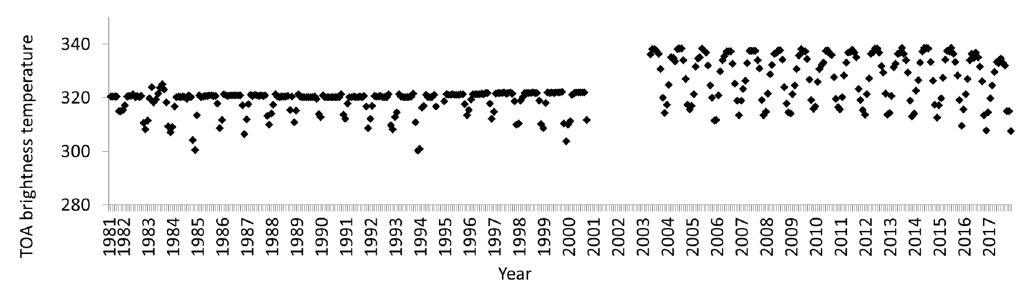
Figure 5. Difference between AVHRR2/3 in a Sahara Desert pixel of channel 3 (3.55–3.93 µm). The saturation between AVHRR2/3 was different: AVHRR2 was saturated at 50 °C and AVHRR3 at 63 °C. Therefore, before 2000 (AVHRR2), the data were distributed in a narrower range than after 2000 (AVHRR3). This implies a significant variation between the sensors.